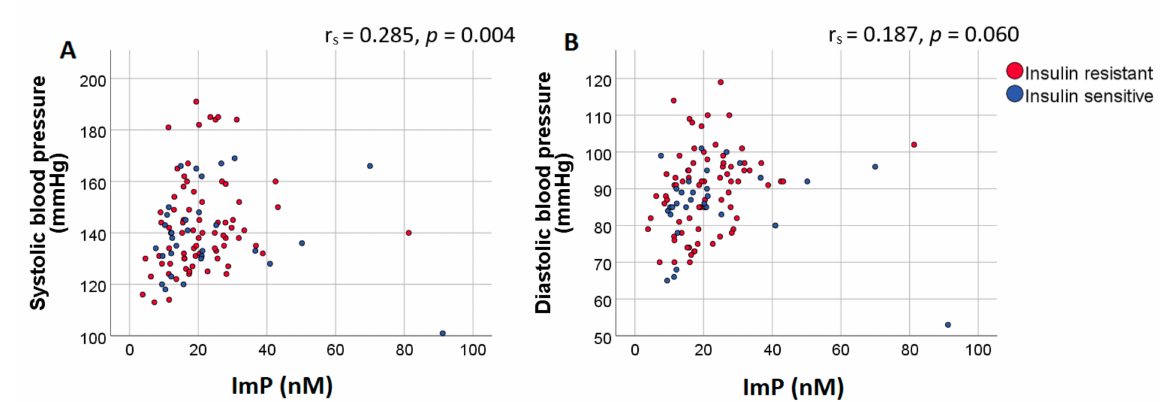
Figure 1. Plasma ImP concentrations positively correlate with diastolic blood pressure. Scatter plot of plasma ImP concentrations (nM) and ( A ) systolic and ( B ) diastolic blood pressure. Results of the Spearman correlation indicated that there was a significant positive association between ImP and diastolic blood pressure. Spearman correlation coefficients and p -values were calculated using partial correlations adjusted for BMI and age. Red dots represent insulin resistant subjects (Rd < 37.3 µ mol · kg − 1 min − 1 ) while blue dots represent insulin sensitive subjects (Rd > 37.3 µ mol · kg − 1 min − 1 ). Abbreviations: ImP, imidazole